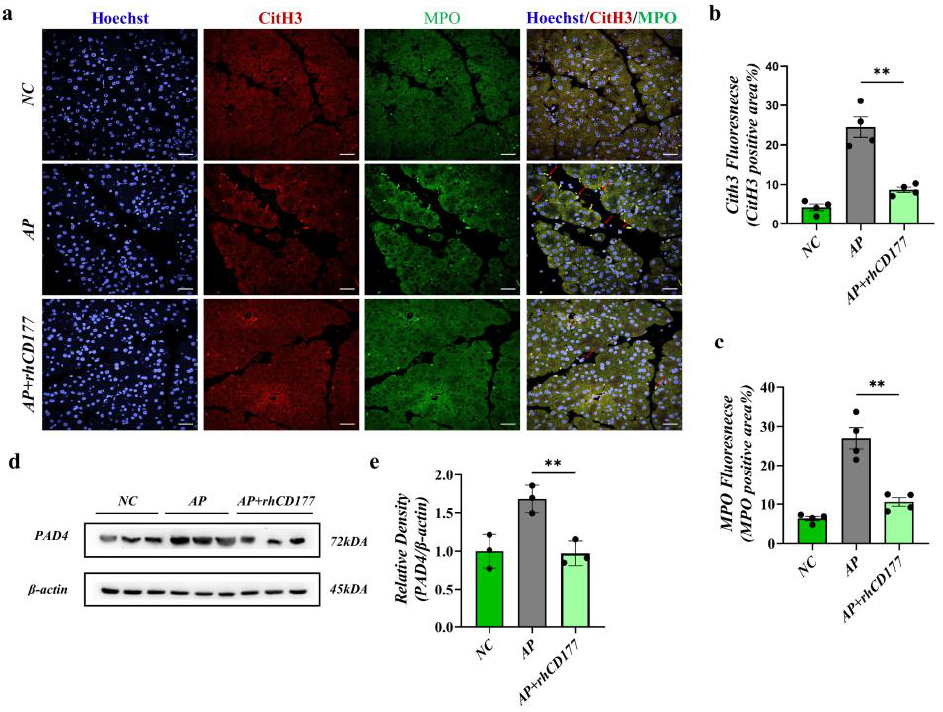
Figure 6. rhCD177 alleviates NET formation in pancreatic tissue of AP mice. ( a ) Representative im- munofluorescence images of CitH3 and MPO at magnifications 600×. Scale bar = 20 μM. ( b ) Densi- tometric analysis of CitH3 fluorescence. ( c ) Densitometric analysis of MPO fluorescence ( n = 4 per group). ( d ) Western blot analysis of PAD4 level in pancreatic tissue. ( e ) Relative protein expression of PAD4; β-actin was used as a control for protein loading ( n = 3 per group). Black dots represent samples. Statistical significance is denoted as ** p < 0.01.